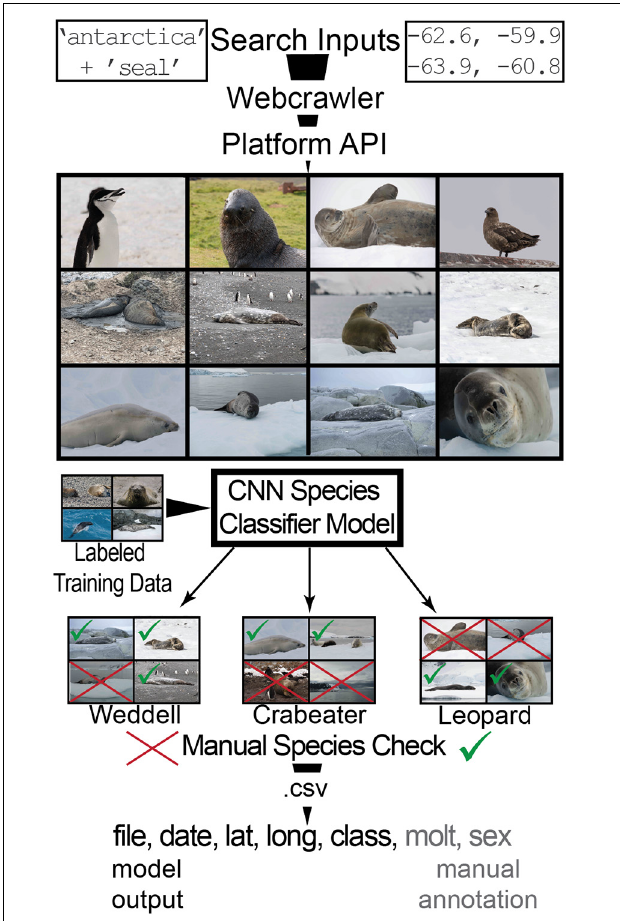
FIGURE 2 | The workflow. Text and search terms are fed to the web-crawler, which interacts with the platform API (in this case, Flickr) to find images. Once downloaded, images are fed to the trained classifier which separates images by species. A manual verification step fixes misclassifications, and manual annotations such as molt and sex can then be added to the output